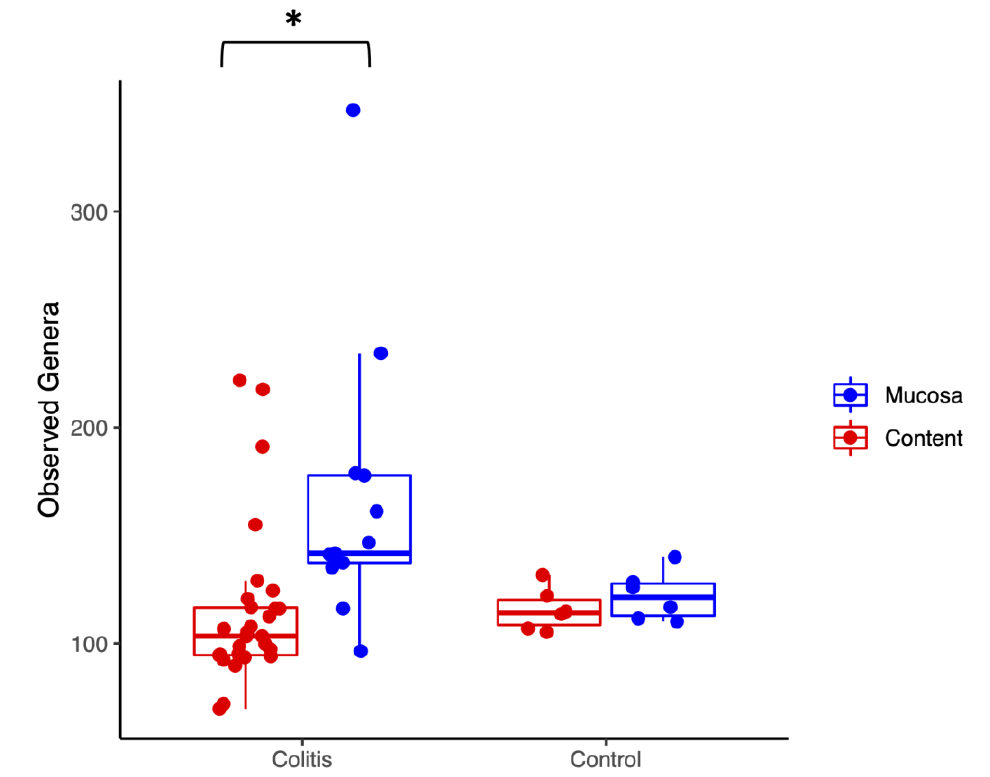
Figure 1. Richness indicated by the number of observed genera found in the mucosal (blue) and luminal content (red) microbiota of healthy horses and horses with colitis, demonstrating statistically higher richness in lumen compared to mucosa of diarrheic horses. * Statistical significant different between groups.